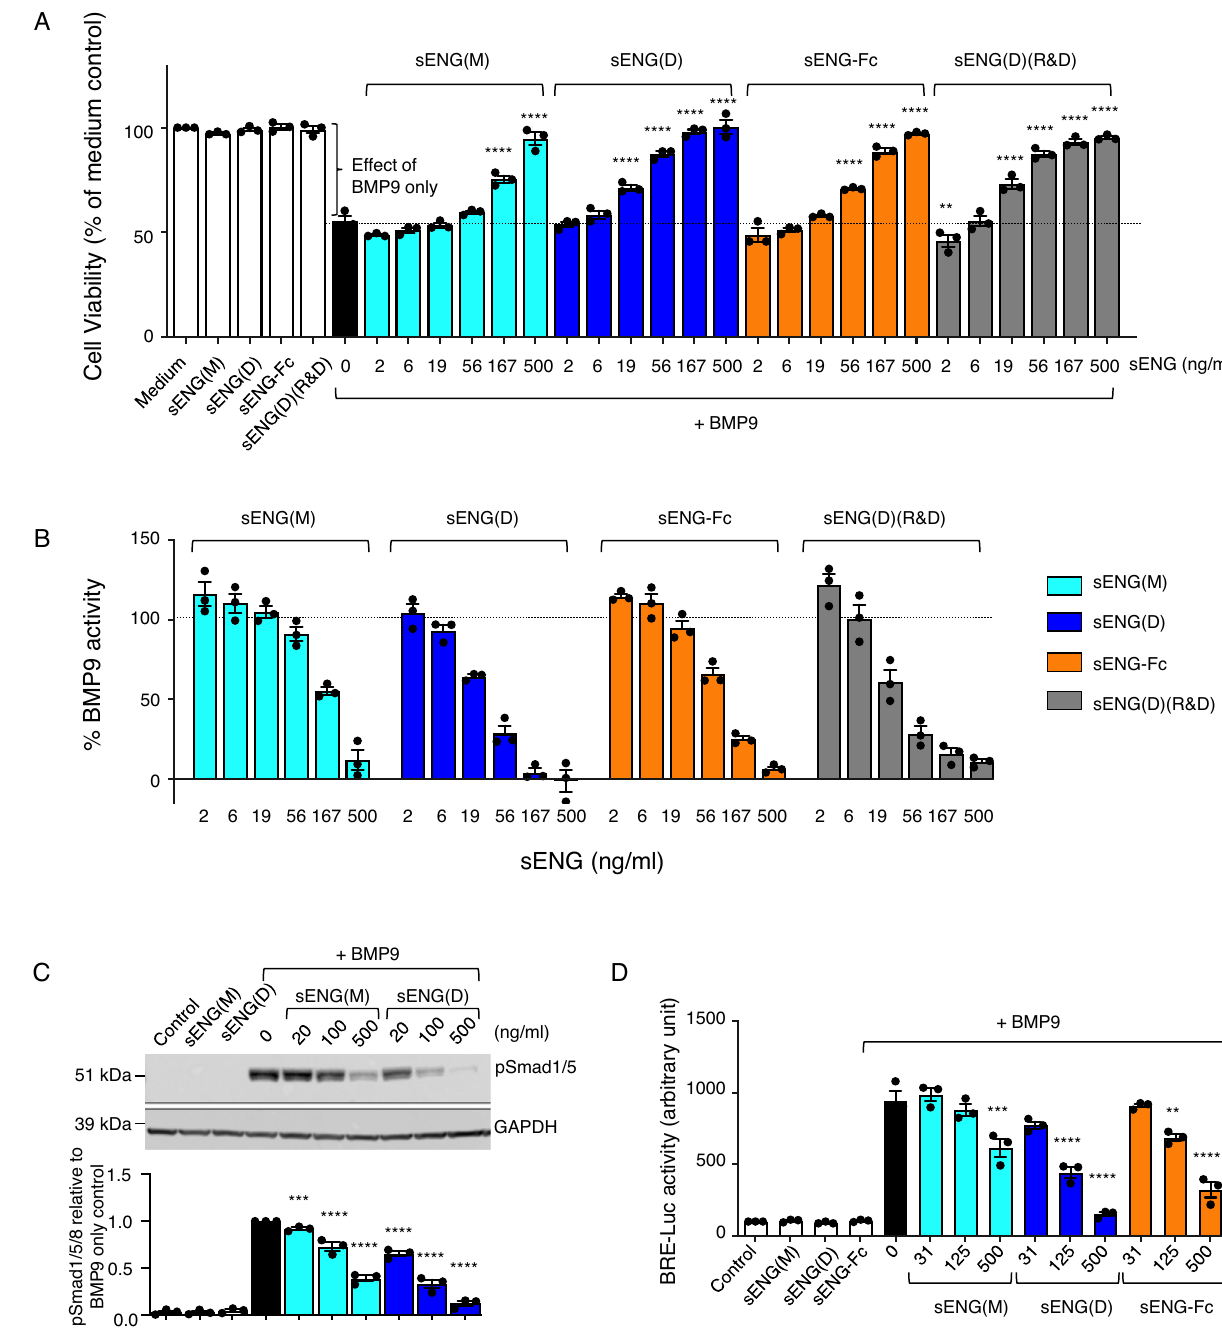
Figure 1. Soluble endoglin (sENG) counteracts BMP9-mediated signaling and apoptosis in myeloma cells. ( A & B ) INA-6 cells were treated with BMP9 (0.125 ng/mL) combined with increasing doses of recombinant sENG variants. Cell viability was measured after 48 h using the CellTiter Glo ATP assay. The experiments were performed three times, with duplicated measurement taken in each experiment. ( A ) Readout of Cell viability as percentage to medium only without treatment. ( B ) %BMP9 activity derived from (A), calculated by the difference between BMP9 treatments and the medium treatment and normalizing the values to the effect of BMP9 only treatment as indicated in (A), using the following equation: 100% x (Viability medium − Viability BMP9+sENG )/ (Viability medium − Viability BMP9 only ). (C) INA-6 cells were treated with BMP9 (0.5 ng/ mL) and increasing doses of sENG(M) or sENG(D) for 1 h. Phosphorylation of SMAD1/5/8 (pSMAD1/5/8) was measured by western blot with GAPDH as a loading control. One representative gel from three independent experiments is shown (upper panel), and the relative pSMAD1/5 levels were calculated by correcting to GAPDH loading control and normalizing to BMP9-treated control (lower panel). Uncropped gels are shown in Supplementary Fig. 1B. ( D ) INA-6 BRE-Luc cells were treated for 18 h with BMP9 (0.4 ng/mL) and increasing doses of sENG(D), sENG(M) or sENG-Fc before the amount of luciferase was measured. In Panels A, C and D, the concentrations of sENG only were 500 ng/mL; the graphs represent Mean ± SEM from N = 3 independent experiments; One-way ANOVA of the BMP9-treated groups, with Dunnett’s multiple comparison against BMP9 alone without sENG (black bar). ** P < 0.01, *** P < 0.001, **** P <